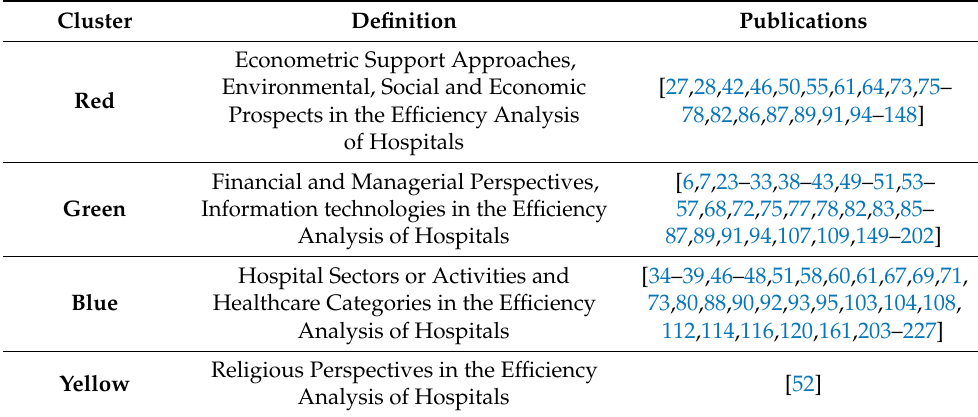
Table 4. Cluster Definitions and